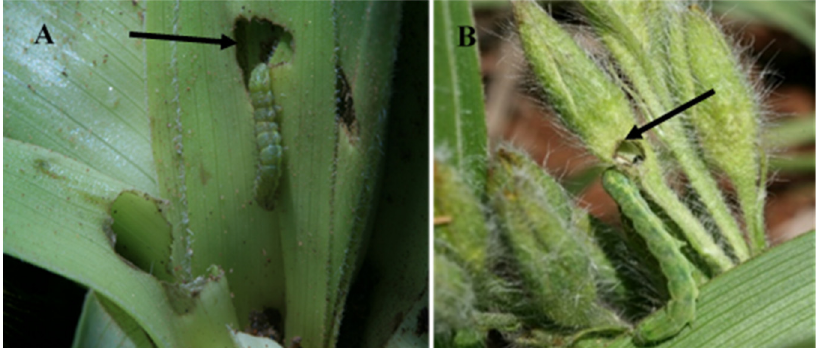
Figure 5. A potential pest and its potential damage on Hypoxis hemerocallidea plants. ( A ) African bollworm ( Helicoverpa armigera ) feeding on the leaves and ( B ) on the seed pods (Source: Agricultural Research Council-Vegetable and Ornamental Plant Research